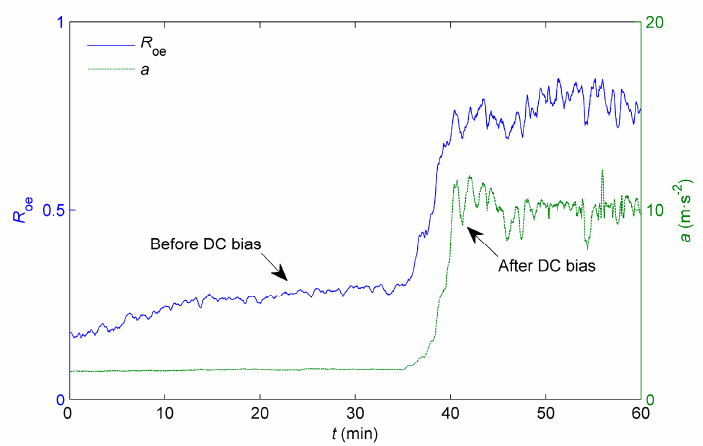
Figure 5. Feature R oe variation process with time.